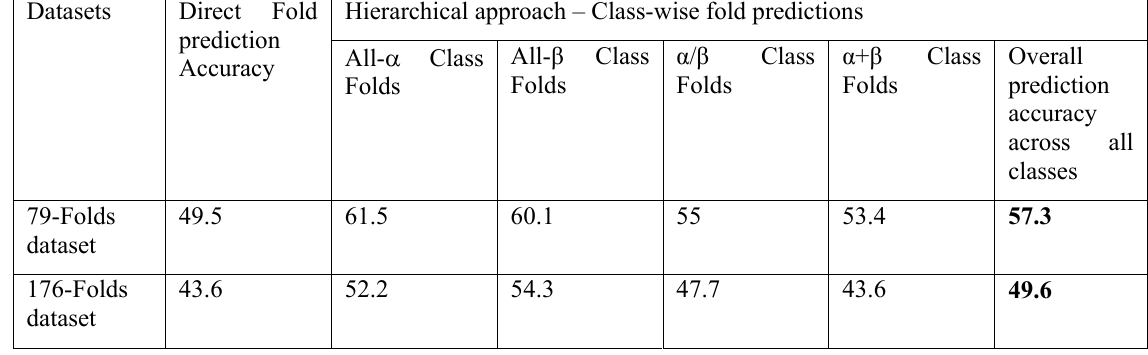
Table 3: The fold prediction accuracies (%) obtained when fold prediction is carried out directly and also when fold prediction is done hierarchically at individual structural class-level. The accuracies reported here are five-fold cross-validation accuracies.